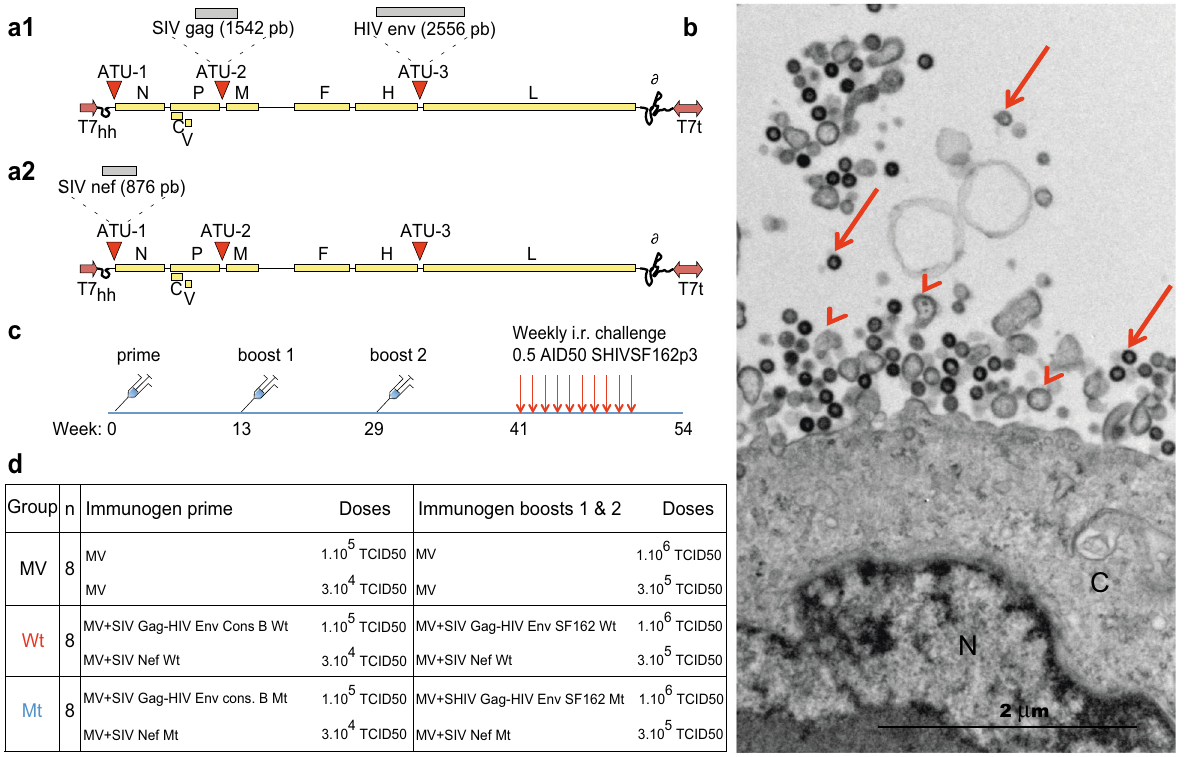
Fig. 1 Vectors, VLP electron microscopy, and vaccine regimen. a1 pMVSchw vector with ATU2 containing SIV gag gene and ATU3 containing HIV env gene WT or mutated. HIV env genes are HIV env cons B subtype for the prime vector and SF162 subtype for boosts 1 and 2. a2 pMVSchw vector with ATU1 containing SIV nef gene WT or mutated. HIV env and SIV nef genes were mutated at their immunosuppressive domains. The MV genes are indicated as follows: N (nucleoprotein), P (phosphoprotein), V and C proteins, M (matrix), F (fusion), H (hemagglutinin), L (polymerase), T7 (T7-RNA polymerase promoter), T7t (T7-RNA polymerase terminator), δ (hepatitis delta virus ribozyme). b Electron microscopy image of Vero cells infected by recombinant MV-SHIV Wt virus (MOI of 0.01, MV-SIV Gag-HIV Env). N nucleus, C cytosol. Arrowheads indicate MV viral particles and arrows gag-forming VLPs. c , d Summary of vaccine: immunization schedule, and repeated low dose of intrarectal SHIVSF162P3 challenges. Prime and boost 1 immunizations were subcutaneous and boost 2 was both subcutaneous and intranasal. Subcutaneous inoculations were performed at two distant sites in the back of